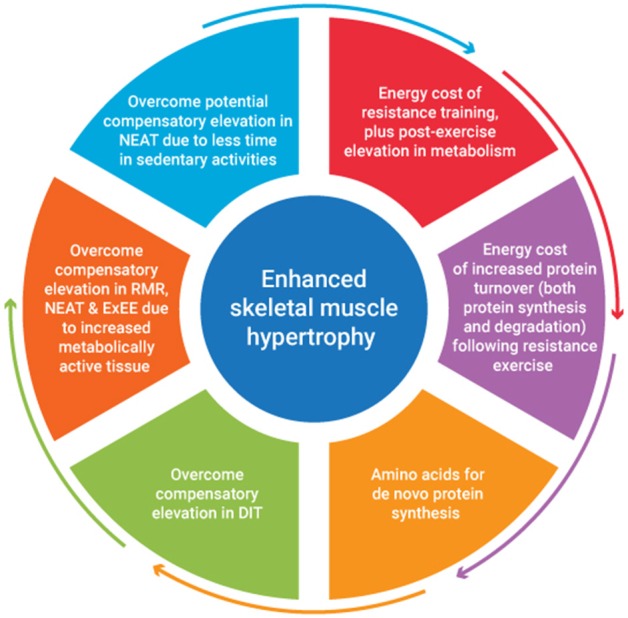
An overview of factors contributing to the energy cost of skeletal muscle hypertrophy.